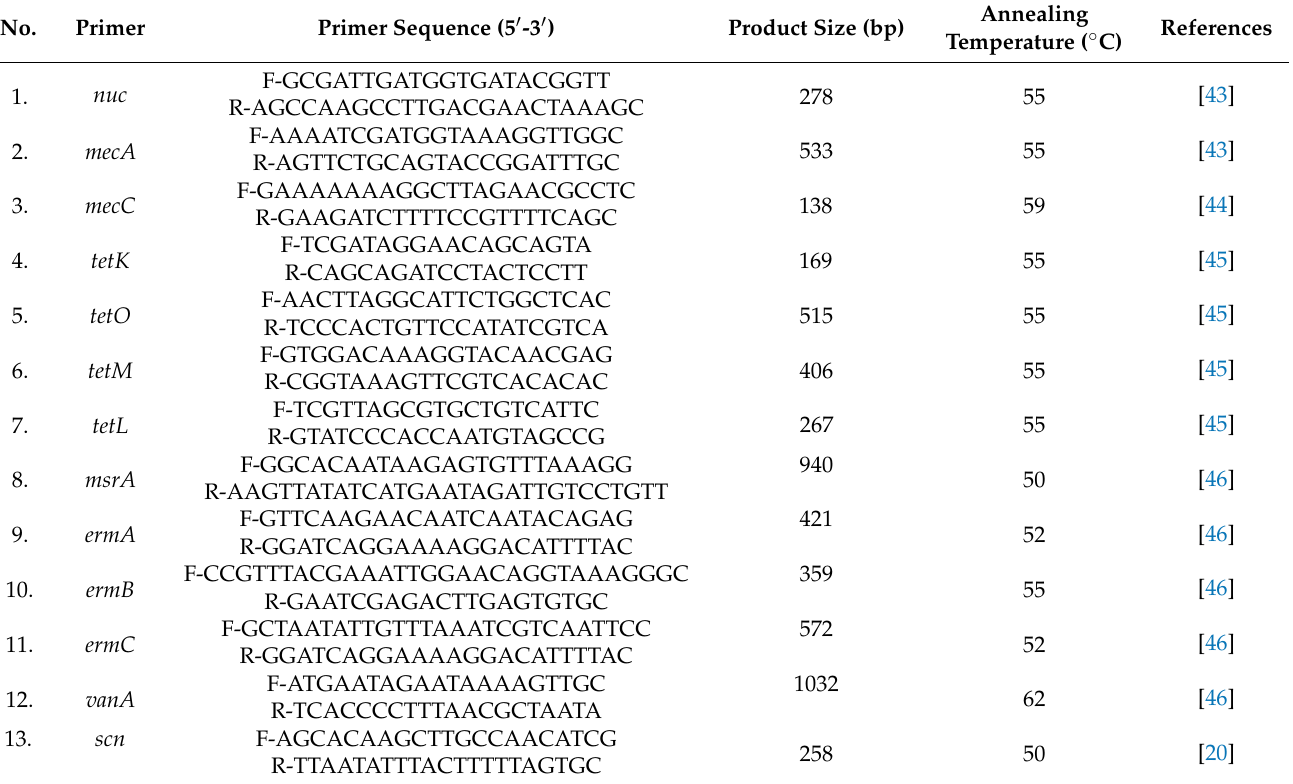
Table 5. List of primers used for the detection of AMR and virulence genes of S. aureus